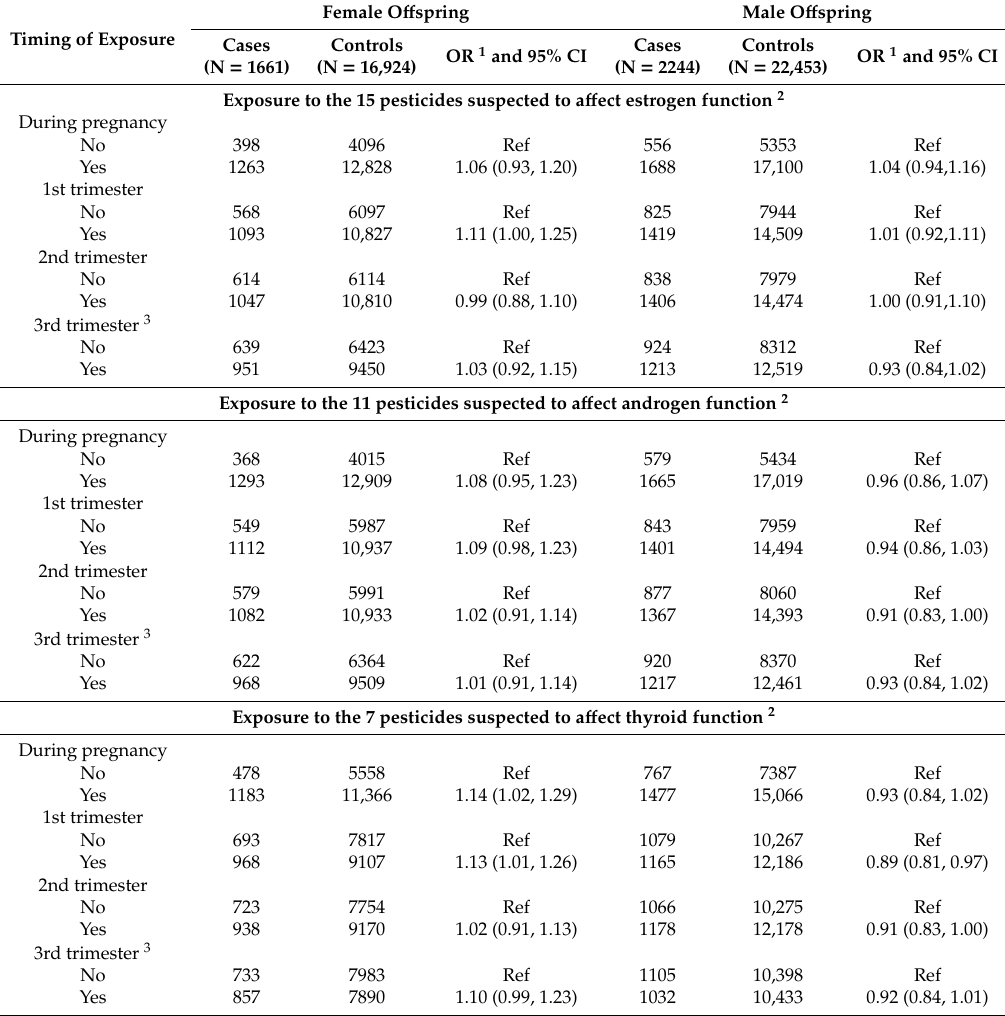
Table 3. OR and 95% CI for cerebral palsy according to pregnancy exposures to the 23 pesticides compounds classified according to potential hormone target a ff